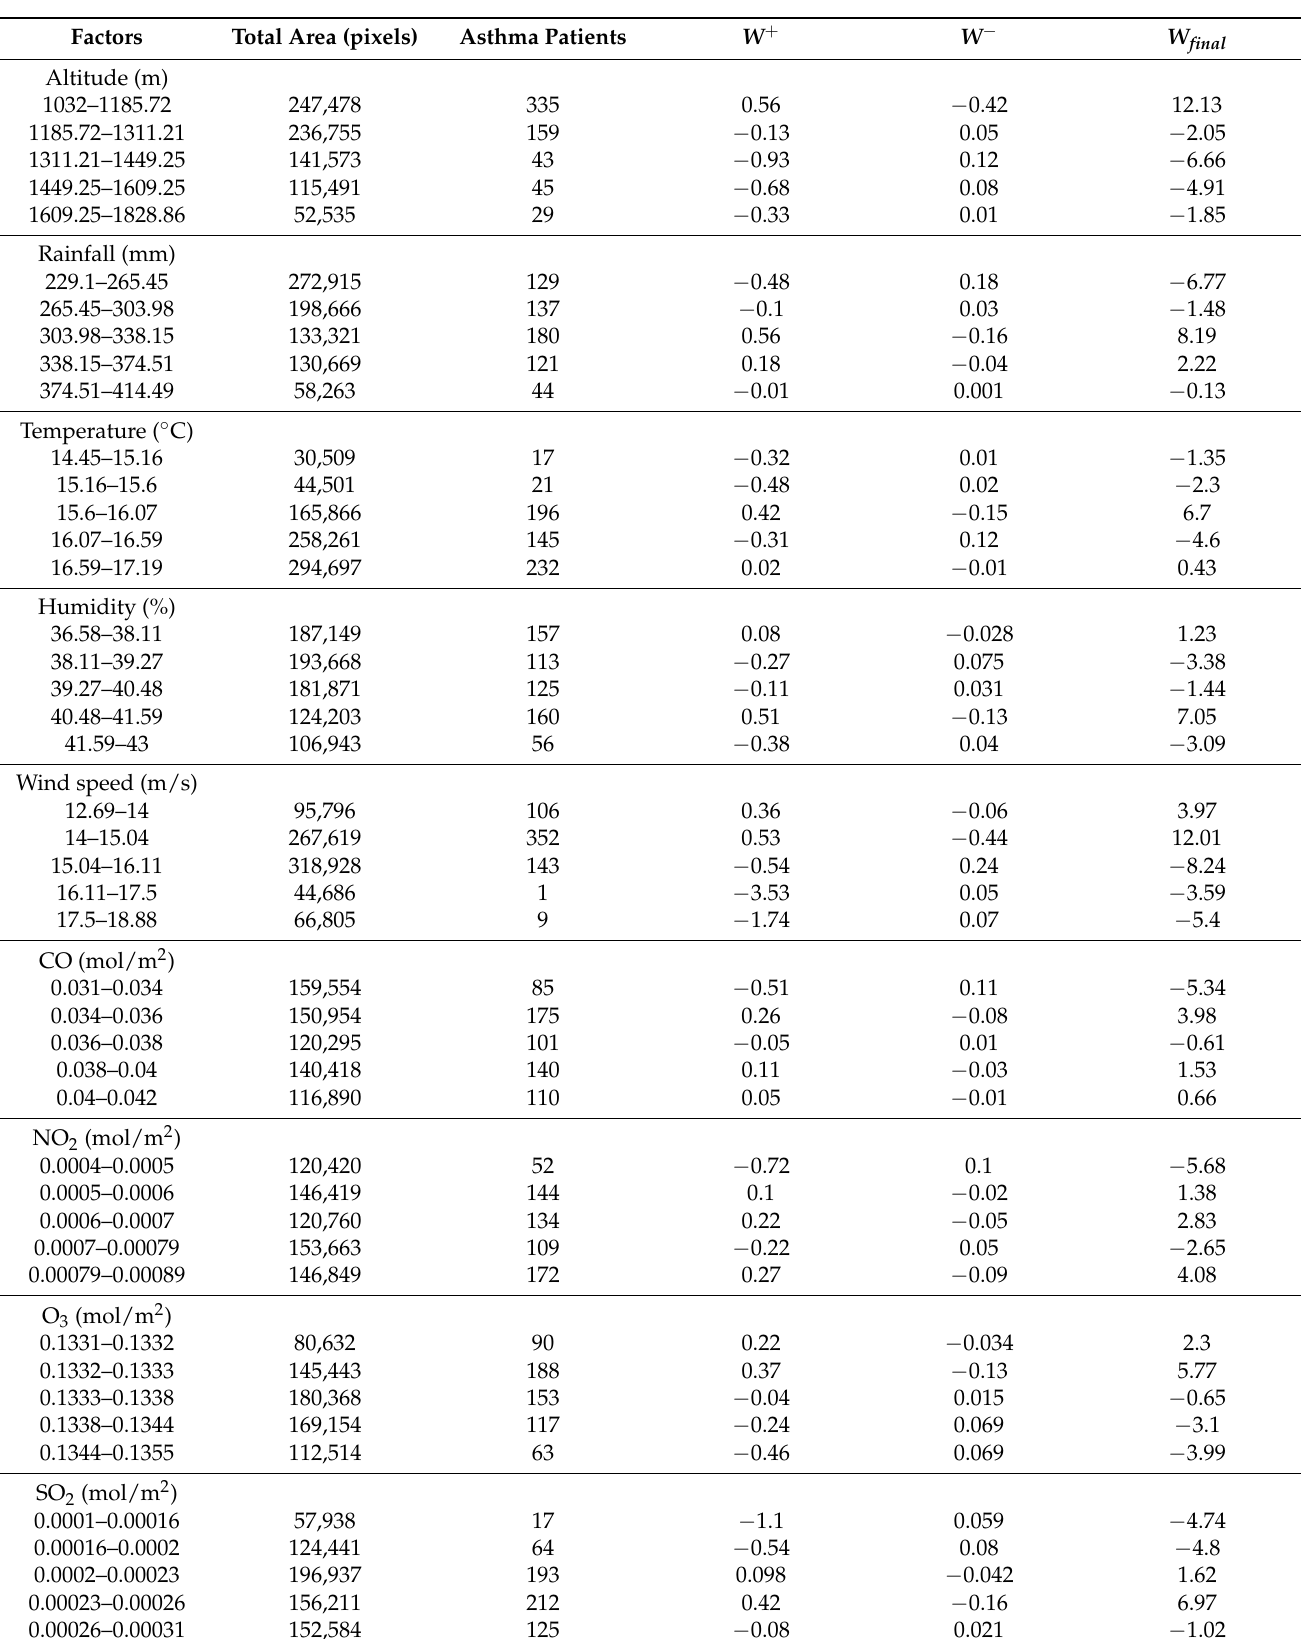
Table 3. Result of WOE